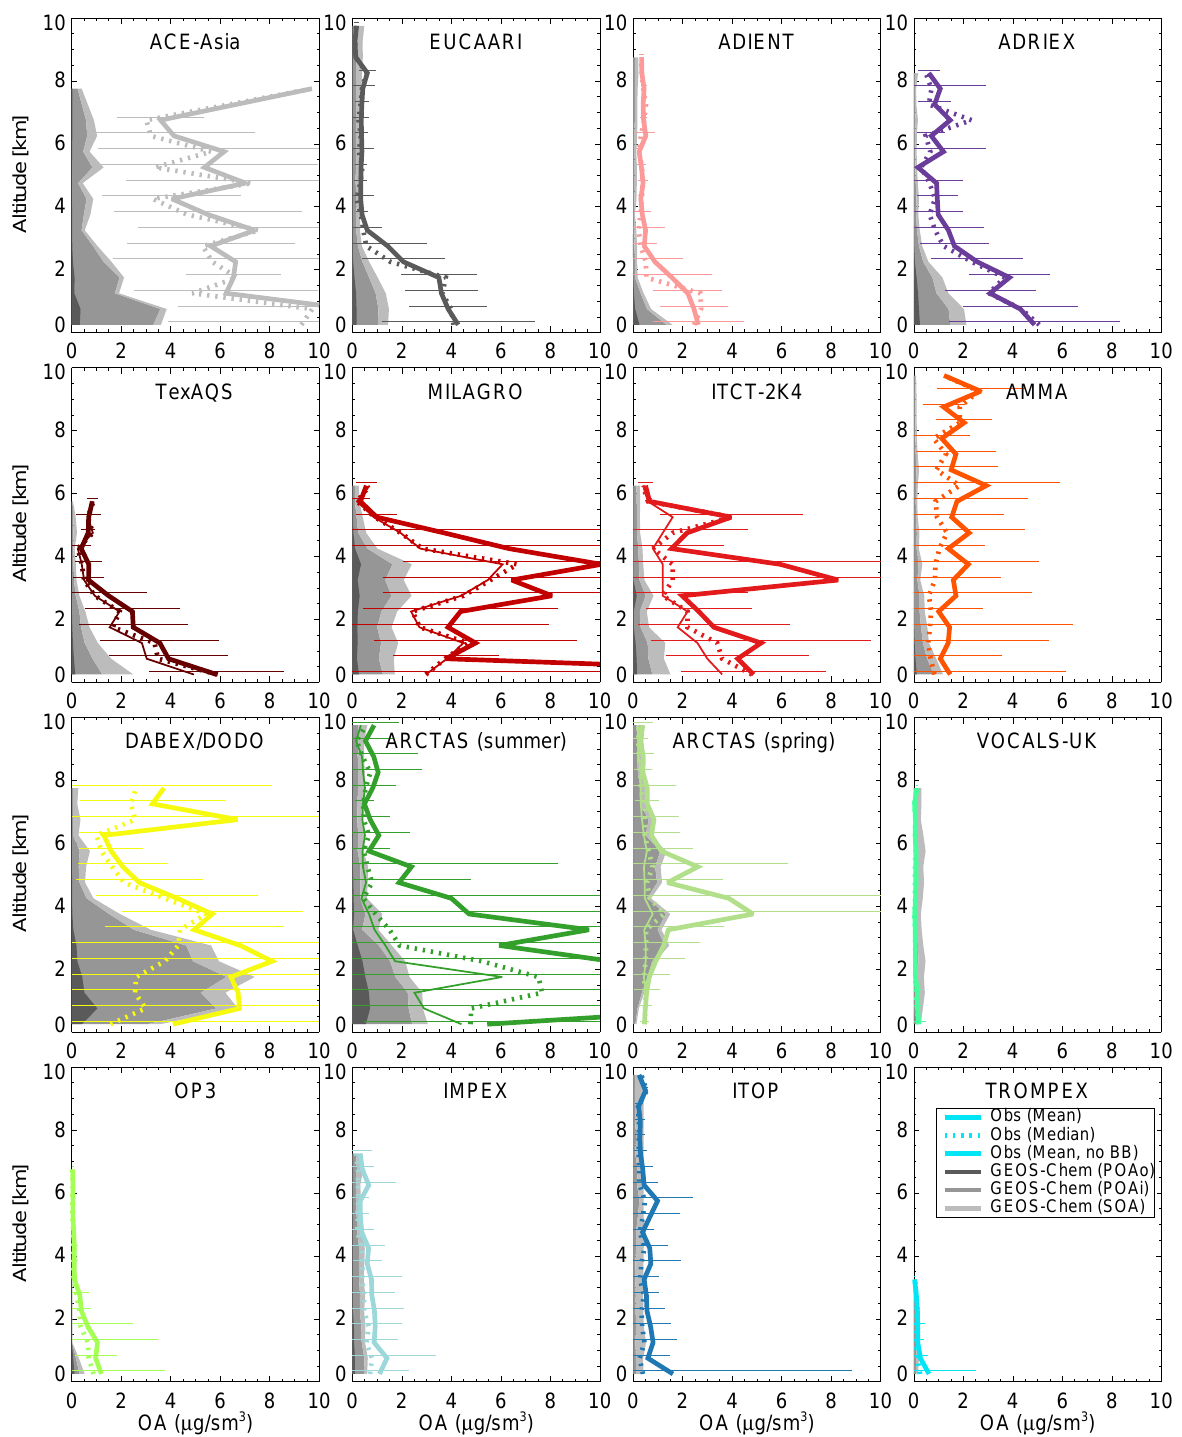
Fig. 3. Mean vertical profile of organic aerosol for 17 field campaigns (color, solid) with the mean GEOS-Chem simulation shown in grey. Model contributions from hydrophobic POA (dark grey), hydrophilic POA (medium grey) and SOA (light grey) are shown. Median observed values at each altitude are shown as dotted lines. Mean observed values with biomass burning plumes removed (see text) are shown as thin colored lines. The standard deviation of the binned observations at each 0.5km interval are also shown. The model simulation is sampled for the dates and locations of each aircraft